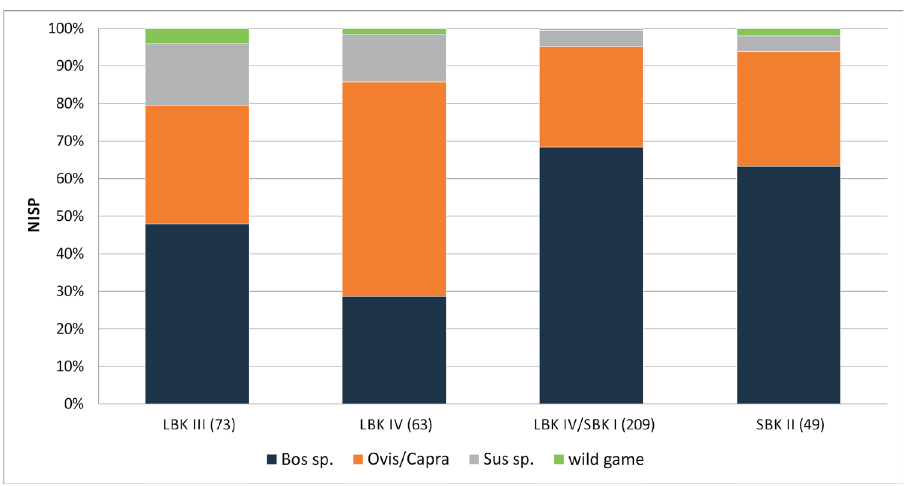
Figure 13 . Comparison among the species frequencies (% NISP). NISP totals for each chronological level are represented in